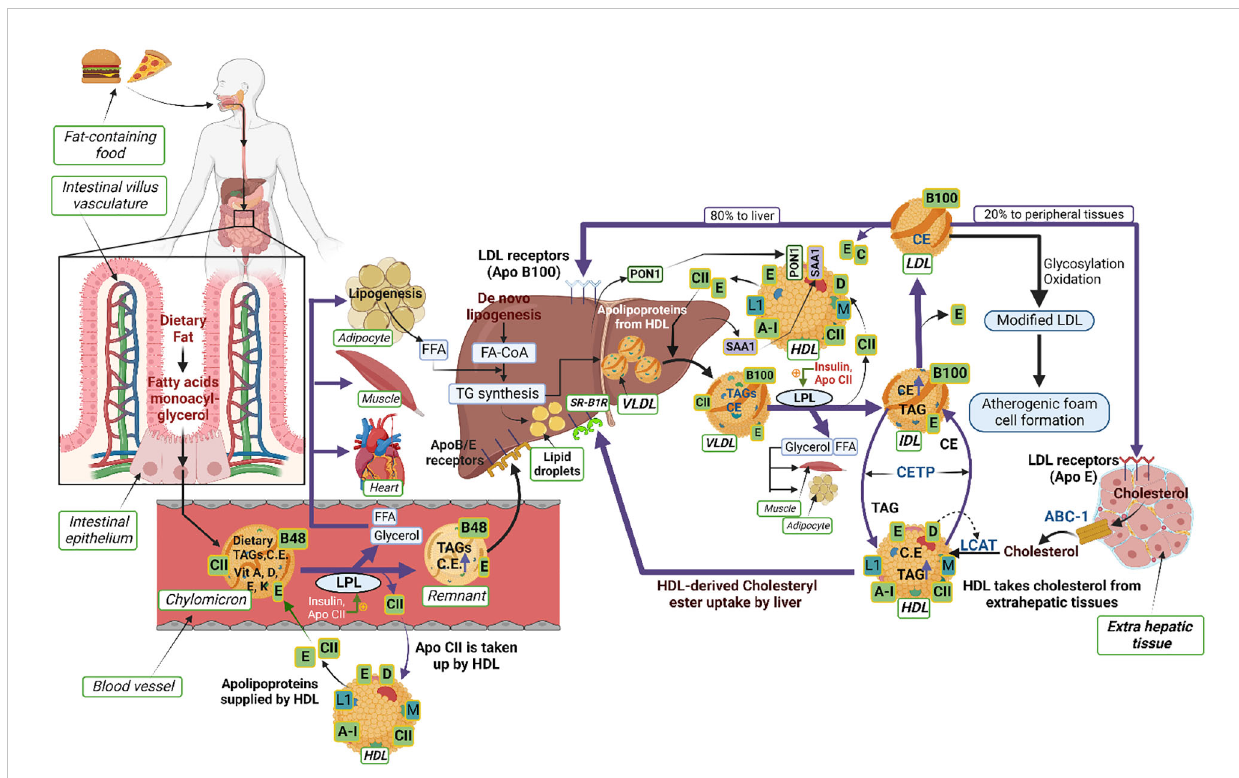
FIGURE 1 Schematic illustrating the interactions of proteins and lipids in the pathways of lipoprotein metabolism. Dietary fats (exogenous triglycerides) are carried by nascent chylomicrons synthesized by the intestine. Chylomicrons are assembled in the intestinal mucosal cells and carry dietary triacylglycerol (TAGs), cholesterol, fat soluble vitamins (vitamin A, D, E, K) and cholesteryl esters (CEs). TAGs account for close to 90% of the lipids in a chylomicron. Chylomicrons are hydrolyzed by an extracellular enzyme called lipoprotein lipase (LPL), which is anchored by heparan sulphate to the capillary wall of most tissues. LPL is activated by insulin and apolipoprotein CII (CII) on circulating chylomicrons; it hydrolyzes the TAGs to yield and free fatty acids (FFAs) and glycerol. In muscle (heart and skeletal muscle), fatty acids are oxidized for energy; in adipose tissue, they are re-esterized as TAGs for storage. Upon being hydrolyzed by LPL, a chylomicron is converted into a chylomicron remnant (which contains lipoproteins, Apo B-48, and Apo E). Chylomicron remnants (Apo B-48, Apo E) enter the liver through the low density lipoprotein (LDL) receptors (Apo B-100, E). Apo CII from chylomicrons is taken back by HDL. De-novo synthesis of fatty acids (endogenous triglycerides) in the liver are carried by nascent very low- density lipoprotein (VLDL) (containing lipoproteins Apo B-100, Apo CII and Apo E). Lipoprotein lipase hydrolyzes TAG to FFAs and the remnant of VLDL is called intermediate density lipoprotein IDL (containing Apo B-100, Apo E) which have lost triglyceride but are rich in cholesterol. The IDL and VLDL remnants (B-100, E) have 2 fates: most frequently, they lose Apo-E and are converted to LDL (B-100) and, less frequently, they are taken up by the liver via the LDL receptor. LDL (B-100) has 2 fates: 80% of LDL enters the liver through the LDL receptor (ApoB-100, E); 20% enters extrahepatic tissues through the LDL receptor (ApoE). LDL is also modi fi ed by glycosylation or oxidation and converted into atherogenic foam cells (in macrophages). HDL acts as a reservoir for different apoproteins and exchanges them with other lipoproteins; it provides Apo CII and E to nascent chylomicrons and VLDL to form chylomicrons (B-48, CII, E) and VLDL (B-100, CII, E). Besides being a reservoir for apoproteins, it serves the function of reverse cholesterol transport. HDL takes cholesterol from extrahepatic tissues through ATP binding cassette (ABC-1) transporter. Lectin- cholesterol acyltransferase (LCAT) in HDL (stimulated by A-1and Apo D) converts cholesterol to cholesteryl ester. Cholesteryl ester transport protein (CETP) mediates exchange of cholesteryl ester for triglyceride from HDL with the other lipoproteins. The liver reuptakes HDL-derived CEs through scavenger receptor class B type 1 (SR-B1). The other apoproteins of HDL are Apo L1 and Apo M. Two other HDL-associated proteins, paraoxonase-1 (PON1) and serum amyloid A1 (SAA1), are synthesized in the liver and later associated with the HDL